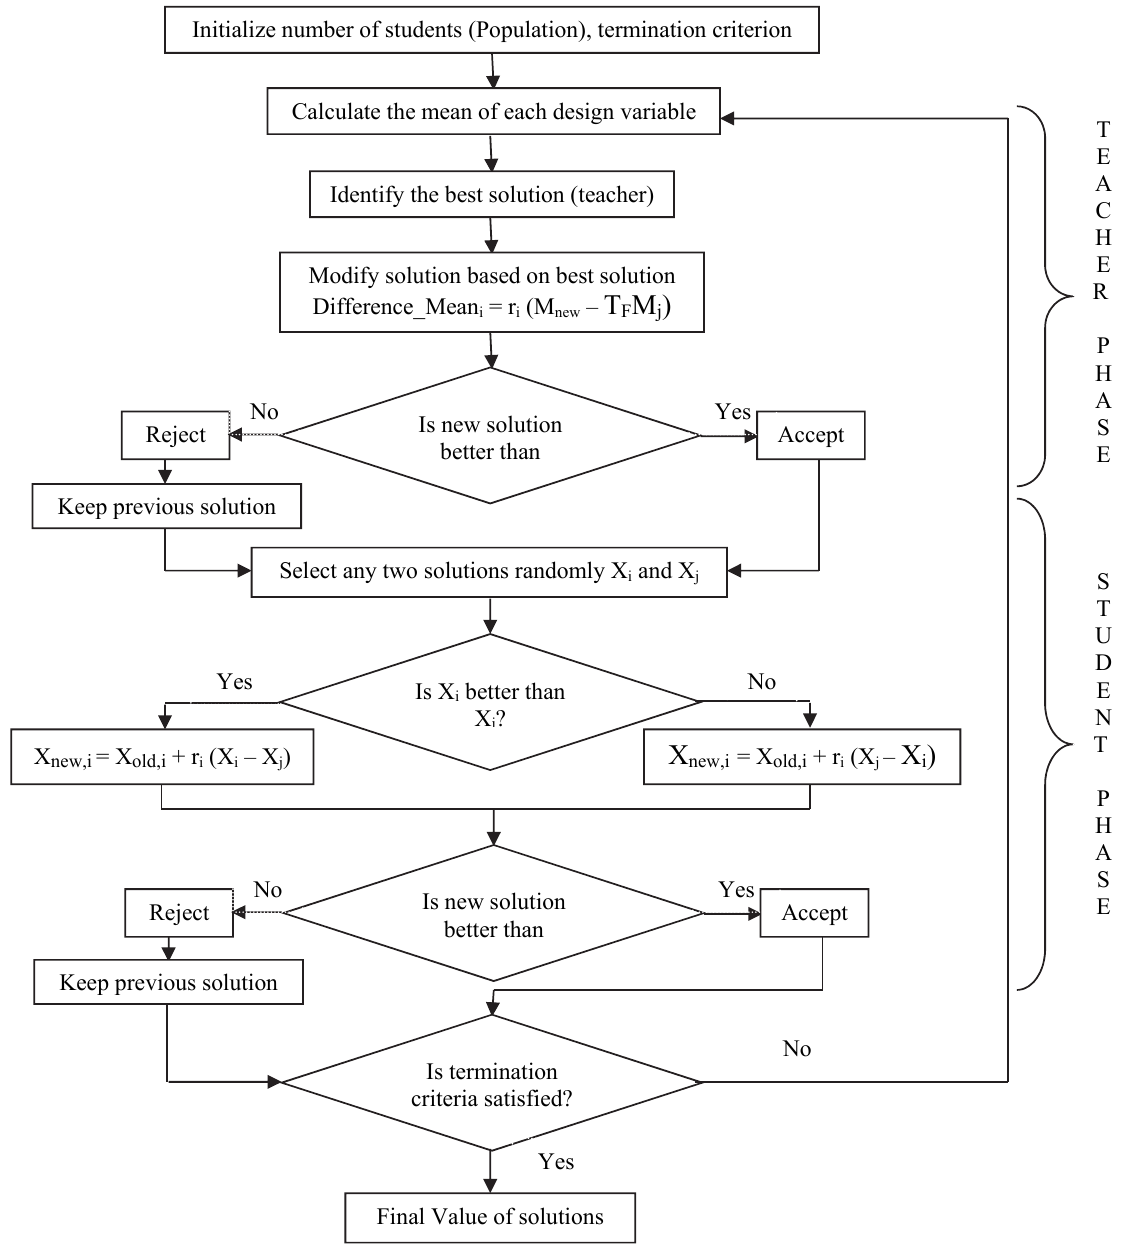
Fig. 1. Flowchart of TLBO algorithm (Rao et al.,